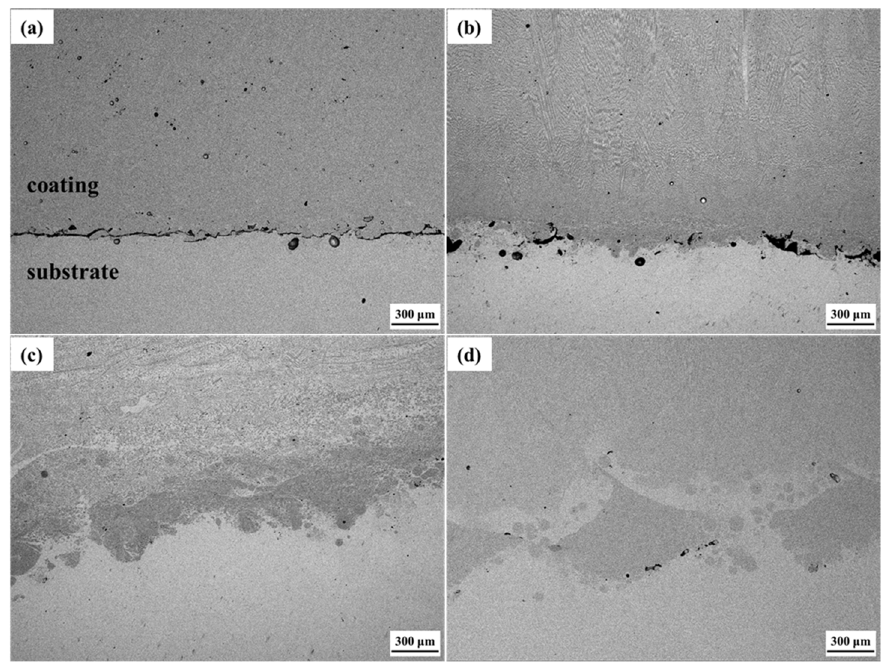
Figure 5. Microstructures of the interfacial zone between the Cu substrate and Cu35Ni25Co25Cr15 HEA coating deposited under different welding currents: ( a ) 130 A; ( b ) 140 A; ( c ) 150 A; ( d ) 160 A.